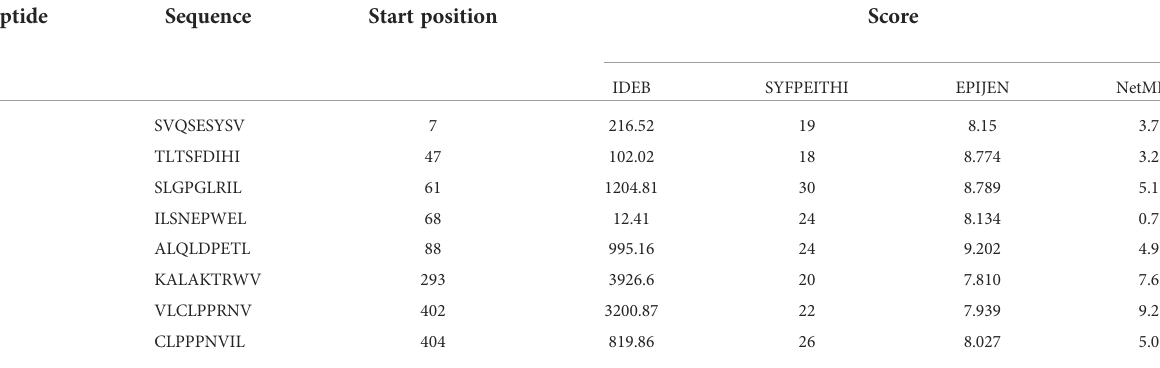
TABLE 1 Prediction of HLA-A*0201 restricted epitope peptides of MAGE-D4 N terminal protein by IDEB, SYFPEITHI, EPIJEN and NetMHC. Peptide